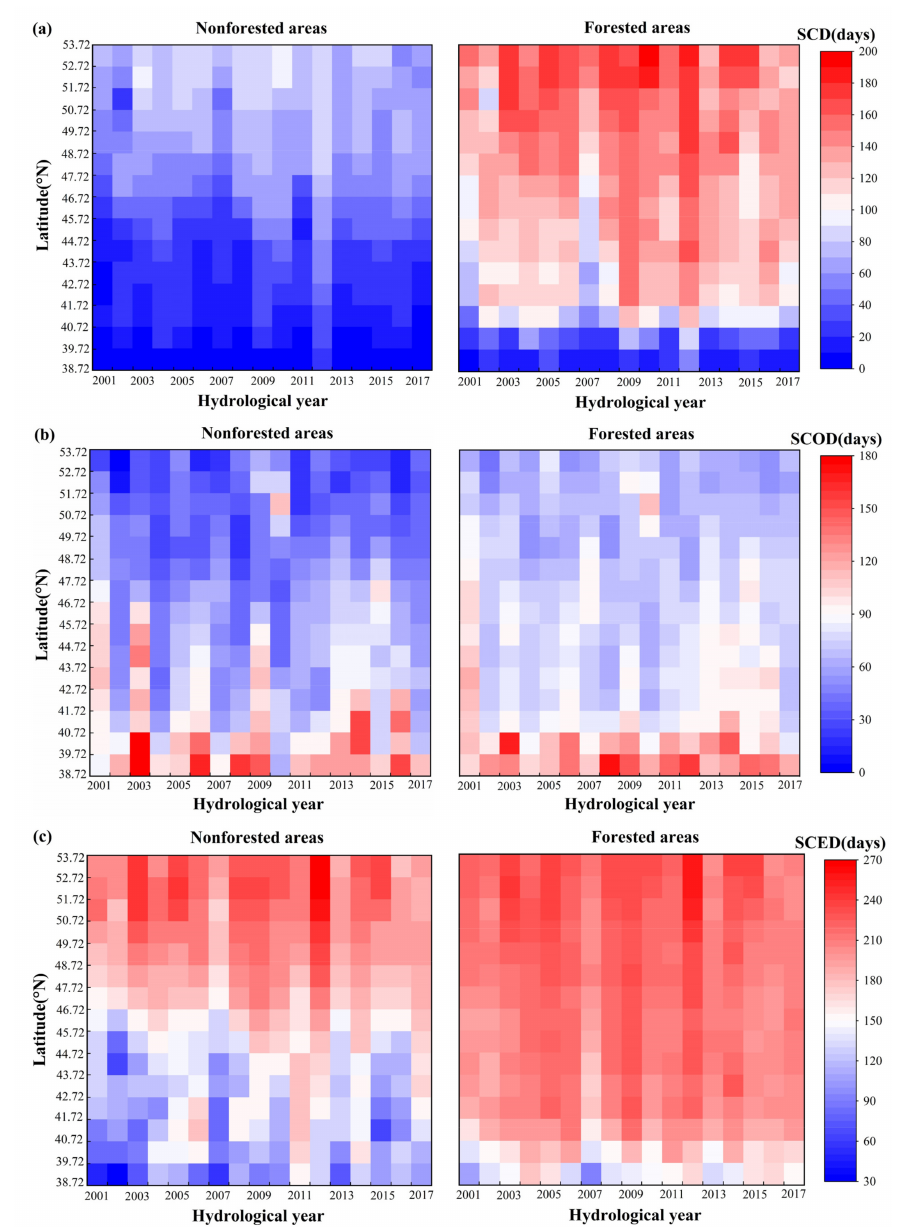
Figure 16. Snow phenology related to latitude in the nonforested and forested areas. ( a ) SCD, ( b ) SCOD, ( c )